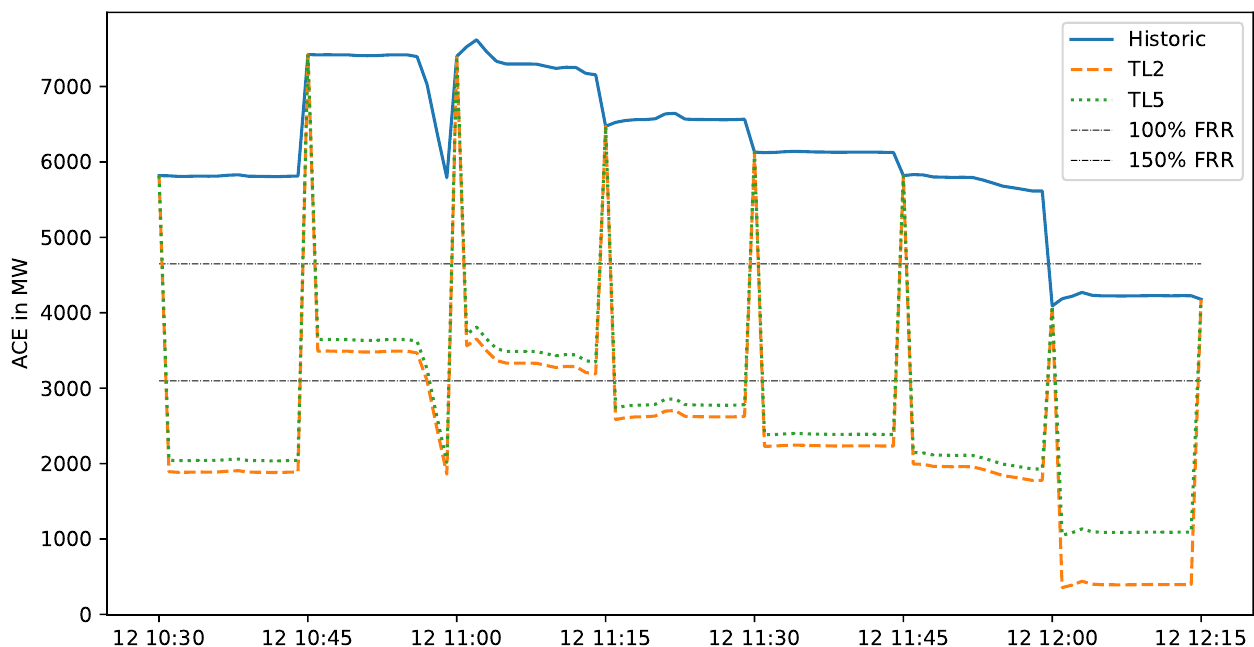
Figure 8. Historic imbalance event 12.06.2019 (Hist), traffic light scenarios (TL2 vs. TL5), and contracted automatic and manual Frequency Restoration Reserves